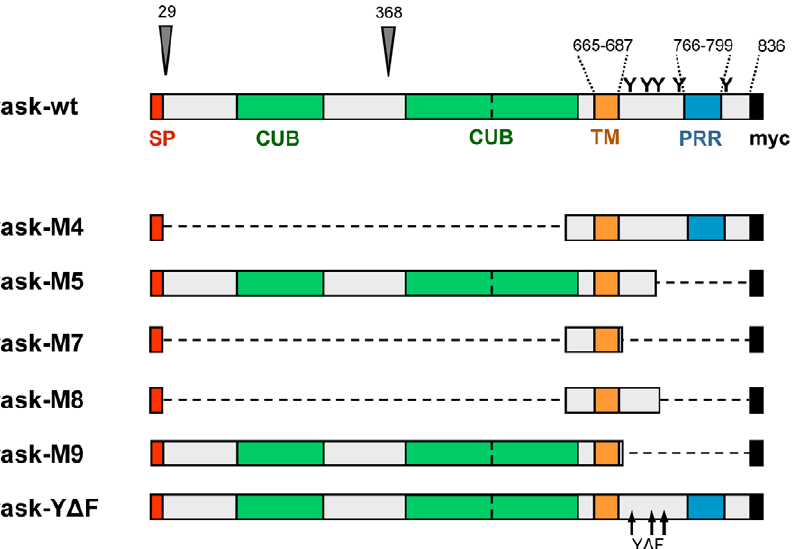
Figure 1. Generation of Trask mutant constructs. Schematic representation of the Trask mutant constructs. All constructs contain the signal peptide and transmembrane regions for proper membrane localization and an in-frame c-terminal myc tag for easy identification. The triangles indicate the naturally occurring cleavage sites after the signal peptide and at Arg368 of the extracellular domain. Abbreviations indicate the signal peptide (SP), CUB domains, transmembrane region (TM), proline-rich region (PRR), and myc tags. The extracellular region homology to CUB domains is low, and the precise region and number of CUB domains is somewhat speculative. The location of the 5 intracellular tyrosines are indicated by Y.